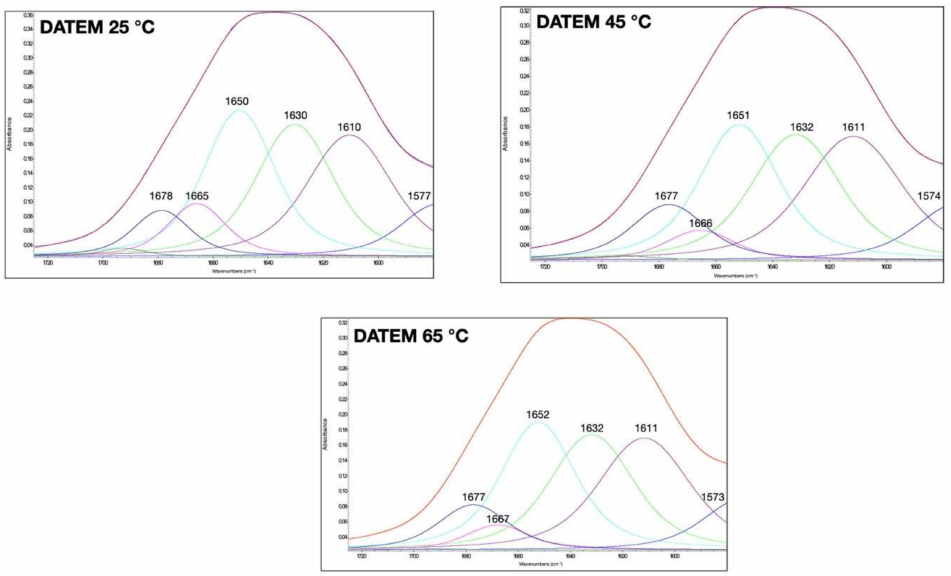
Figure 3. Amide I band of gluten at 25, 45, and 65 ◦ C and with diacetyl tartaric acid ester of monoglycerides (DATEM; 0.6%) treatment. The secondary structure determination by the curve- fitting procedure is